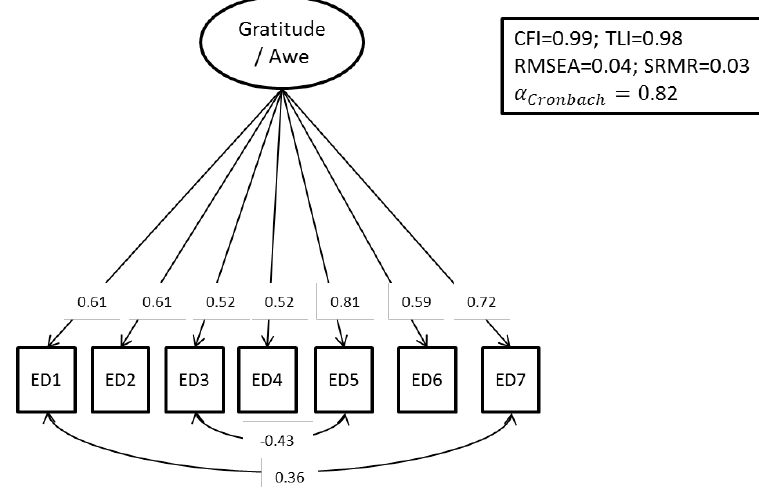
Figure 1. SEM for Gratitude/Awe (GrAw-7).